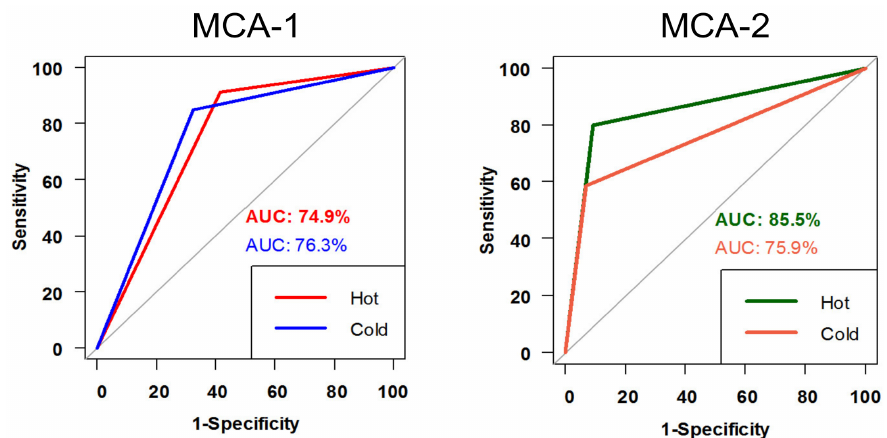
Figure 2. ROC curve for MCT for both warm & cold stimulation among non-HSN patients by using the two formulas: MCA-1 and MCA-2. (ROC curve: receiver operating characteristic curve, MCT: monothermal caloric test, HSN: horizontal spontaneous nystagmus).